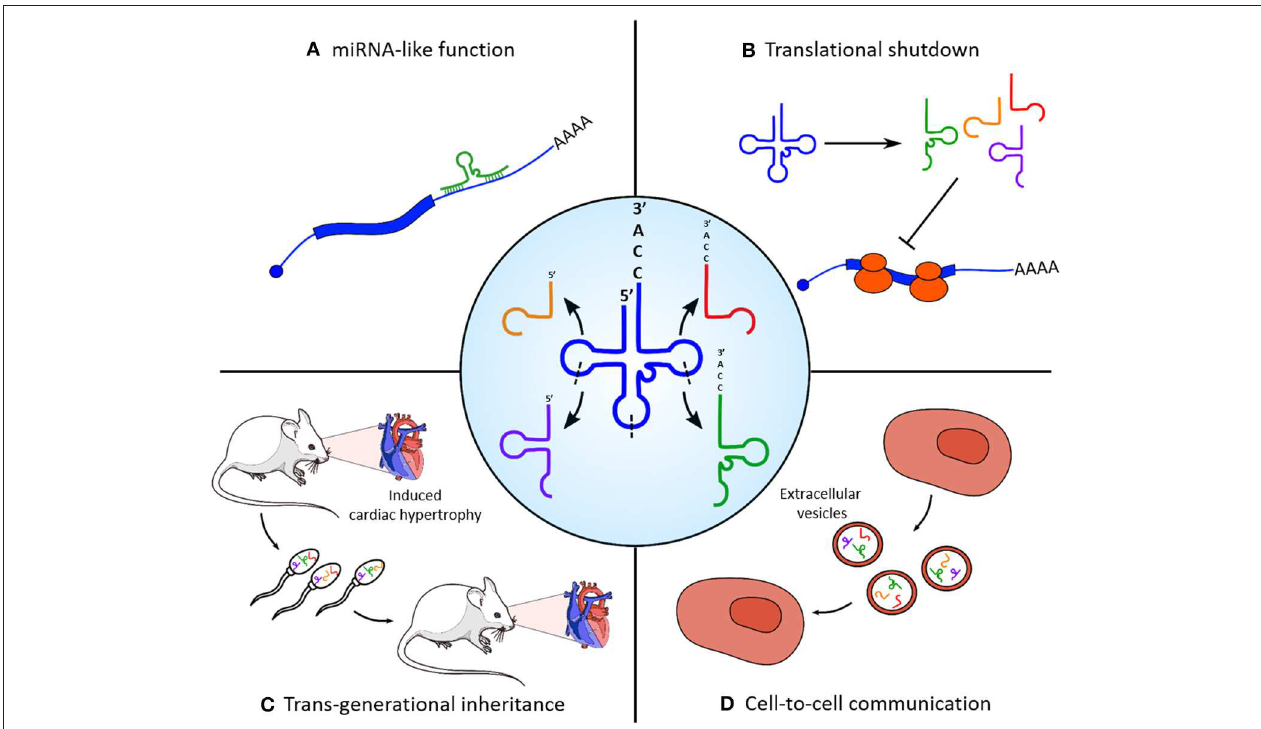
FIGURE 1 | Functional roles of tRNA-derived fragments (tRFs) in skeletal and cardiac muscle homeostasis. Central panel: tRNAs are processed into different categories of tRFs by enzymatic cleavage on specific sites (indicated with dashed lines). (A) tRNA fragments can target the 3 ′ untranslated region (UTR) of protein-coding transcripts (e.g., Kassiri et al., 2009) and regulate their stability and translation efficiency with a microRNA (miRNA)-like mechanism. (B) Massive cleavage of specific tRNA species in stress conditions induces a rapid translational blockade. (C) Accumulation of tRFs in the sperm is responsible for the non-genetic transmission of myocardial hypertrophy phenotypic traits in the offspring. (D) tRFs produced from myoblasts are selectively loaded in extracellular vesicles and could act as mediators of cell-to-cell